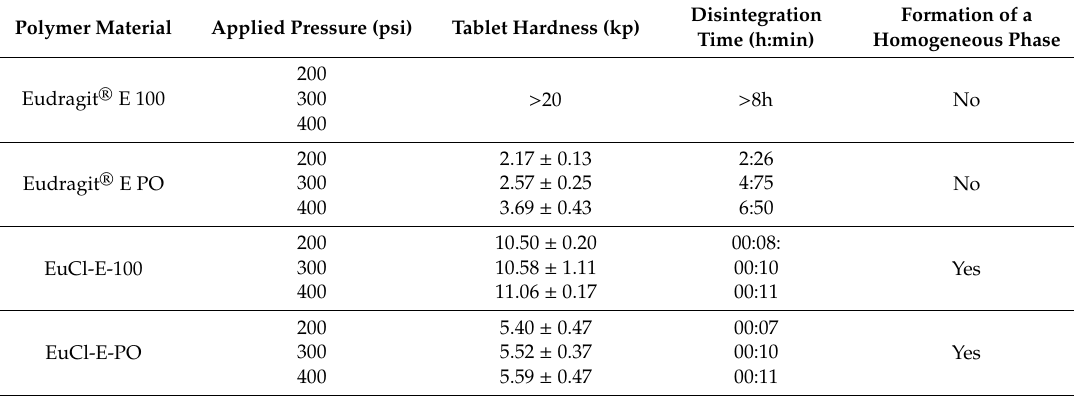
Table 5. Results of hardness, disintegration time and formation of homogenous phase of polymeric tablets elaborated with Eudragit ® E and EuCl-E